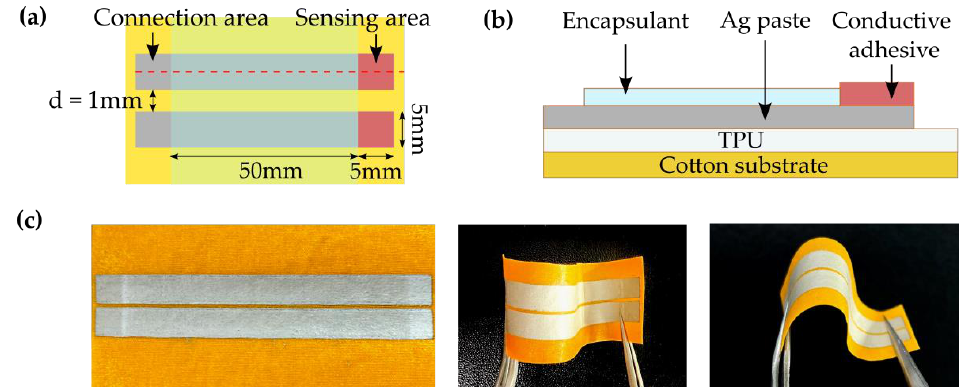
Figure 2. ( a , b ) Schematics on the top ( a ) and side ( b ) view of the textile-based skin hydration sensor. ( c ) Digital images of the textile-based skin hydration sensor.